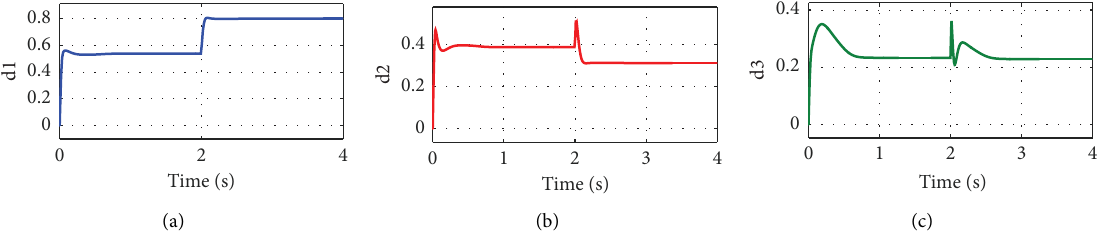
Figure 20: Duty cycles in the second operation mode. (a) Duty cycle of S1, (b) duty cycle of S2, and (c) duty cycle of S3.